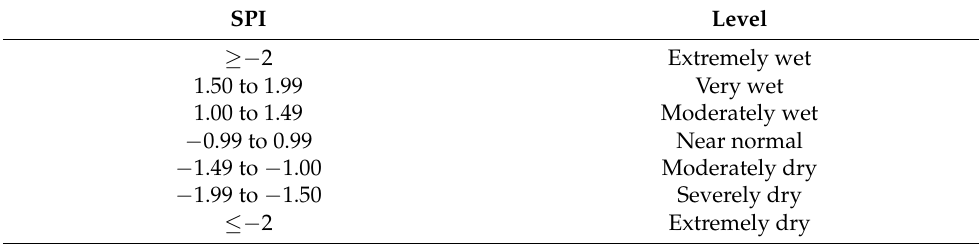
Table 2. Standardized precipitation index (SPI) values and relative drought conditions